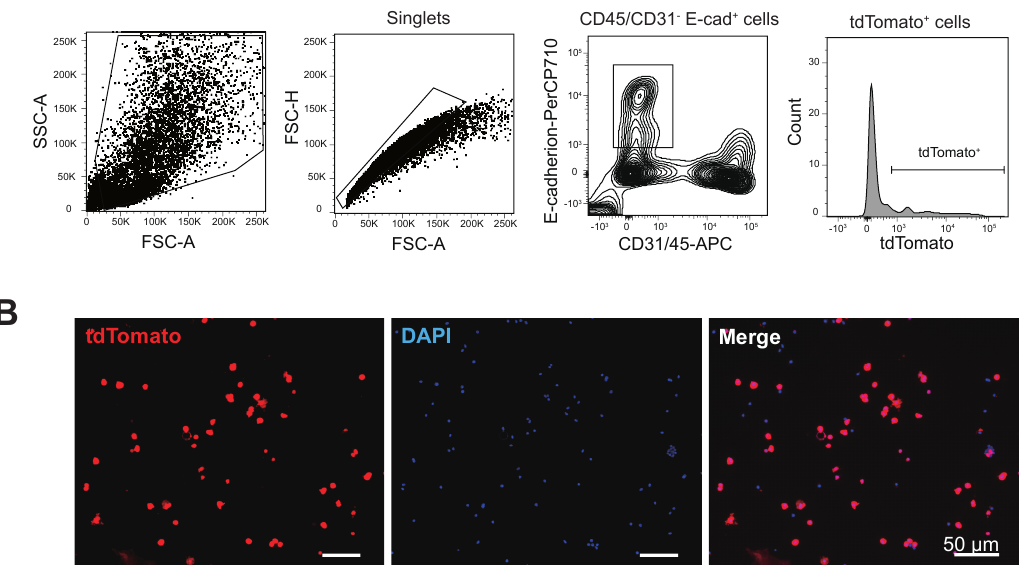
Figure 1. Sorting of tdTomato + cells from ACID;R26tdTomato mice. ( A ) Flow cytometry strategy for sorting AT1 cells. CD45 / CD31 negative, E-cadherin positive, tdTomato positive cells were sorted; 31% ± 10% ( n = 3) of epithelial cells from test mice were positive for tdTomato (panel 4). The box in the third panel delineates the CD45 / CD31-negative and E-cadherin-positive populations. ( B ) Immunofluorescence images of cytospins after fluorescence-activated cell sorting (FACS). Approximately 80% of cells are positive for